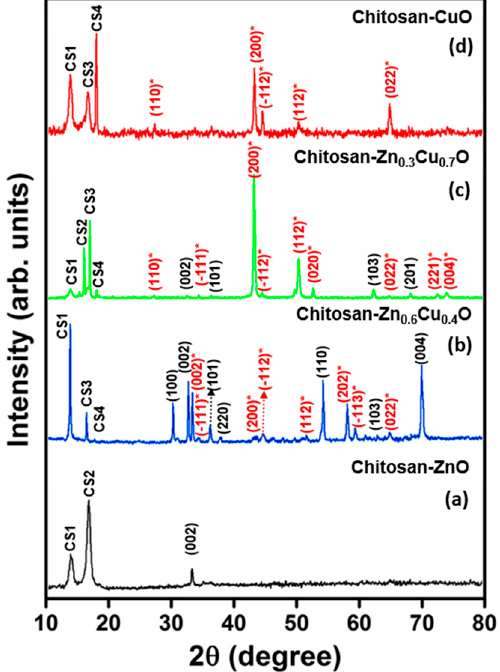
Figure 2. XRD patterns of electrosynthesized composite thin films: ( a ) chitosan-ZnO; ( b ) chitosan-Zn 0.6 Cu 0.4 O; ( c ) chitosan-Zn 0.3 Cu 0.7 O; and ( d ) chitosan-CuO (red color with * indexed peaks are CuO-based lattice planes, black color indexed peaks are ZnO-based lattice planes, and chitosan-based peaks are indexed with prefix CS).